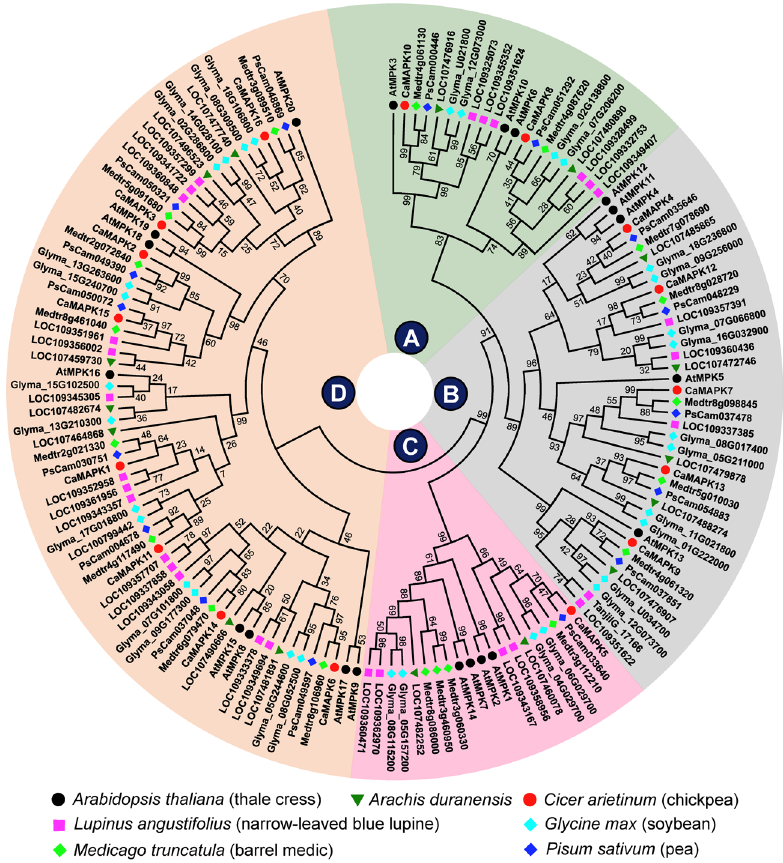
Figure 2. Maximum likelihood phylogeny of MAPKs from six legumes and Arabidopsis. The MAPKs are divided into four groups A–D marked at the centre. Each group is shaded with different colour for easy visualization. The protein sequence alignment was performed on PROMALS3D server and phylogeny was constructed using MEGA7.0.21 using parameters described in Supplementary Table S2 legend. Phylogeny was validated by bootstrap values that were derived from 1000 iterations. A detailed phylogenetic relationship within MAPKs of 16 legume species is illustrated in Supplementary Table